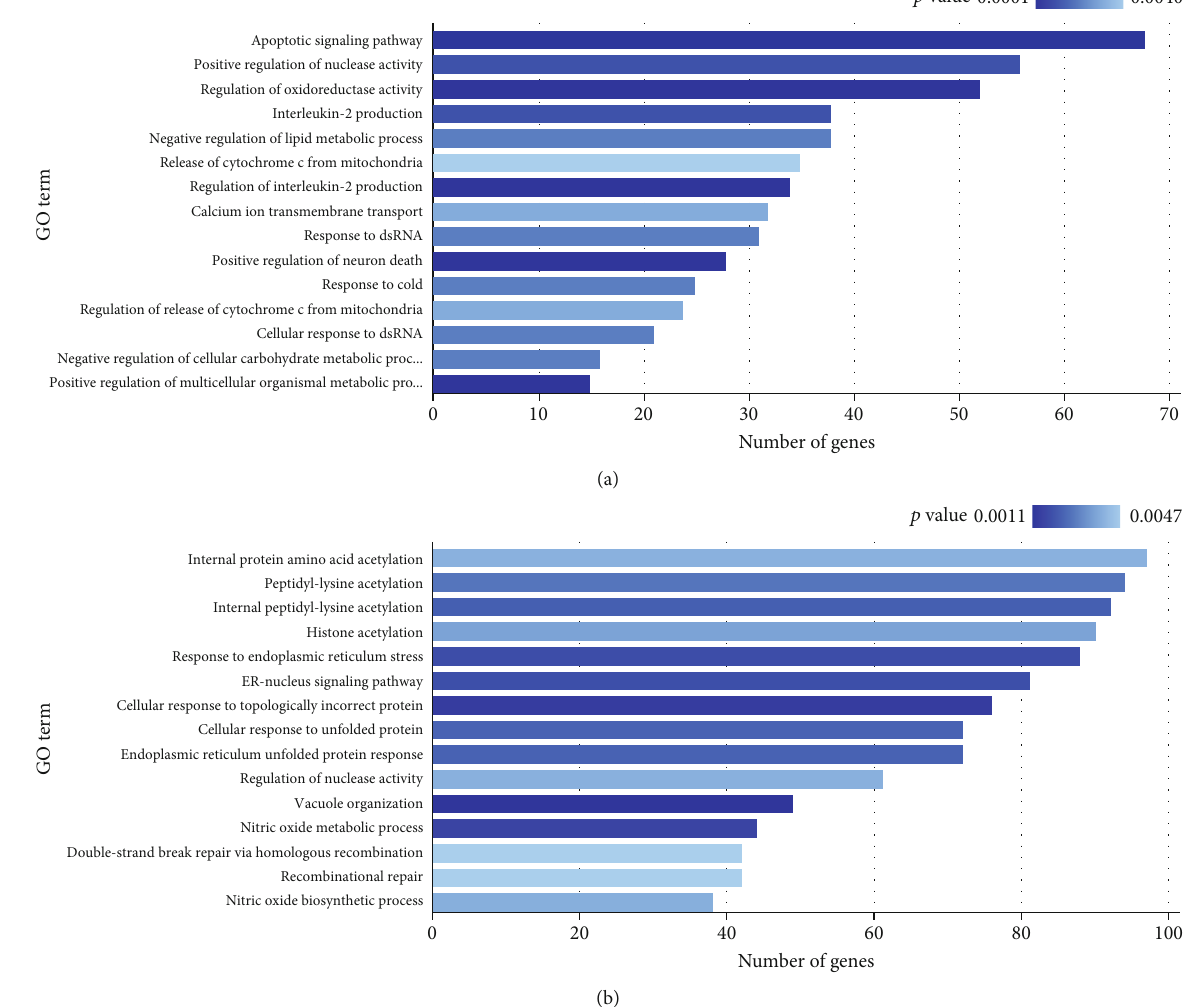
Figure 1: Biological processes that were found as di ff erentially expressed/enriched in peripheral blood mononuclear cells (PBMCs) of T1D patients compared to the control group. (a) Gene set analysis (GSA) showing the fi rst 15 biological processes related to signi fi cantly expressed genes in T1D patients compared to controls. (b) Gene set enrichment analysis (GSEA) showing the fi rst 15 biological processes linked to signi fi cantly enriched genes in T1D patients compared to the controls. Only biological processes with p < 0 : 005 are